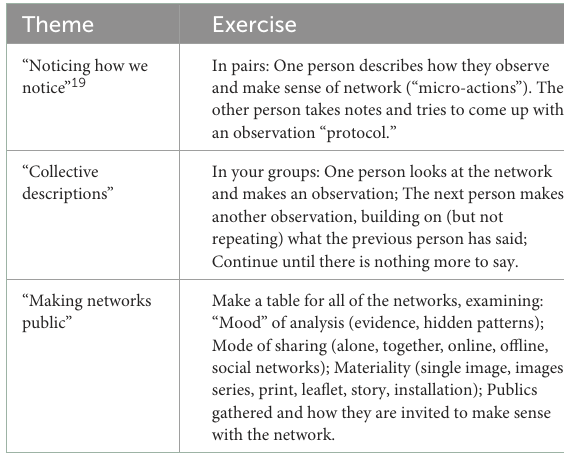
TABLE 1 Observation protocols from “doing things with networks” class as part of Big Data in Culture & Society MA programme at Department of Digital Humanities, King’s College